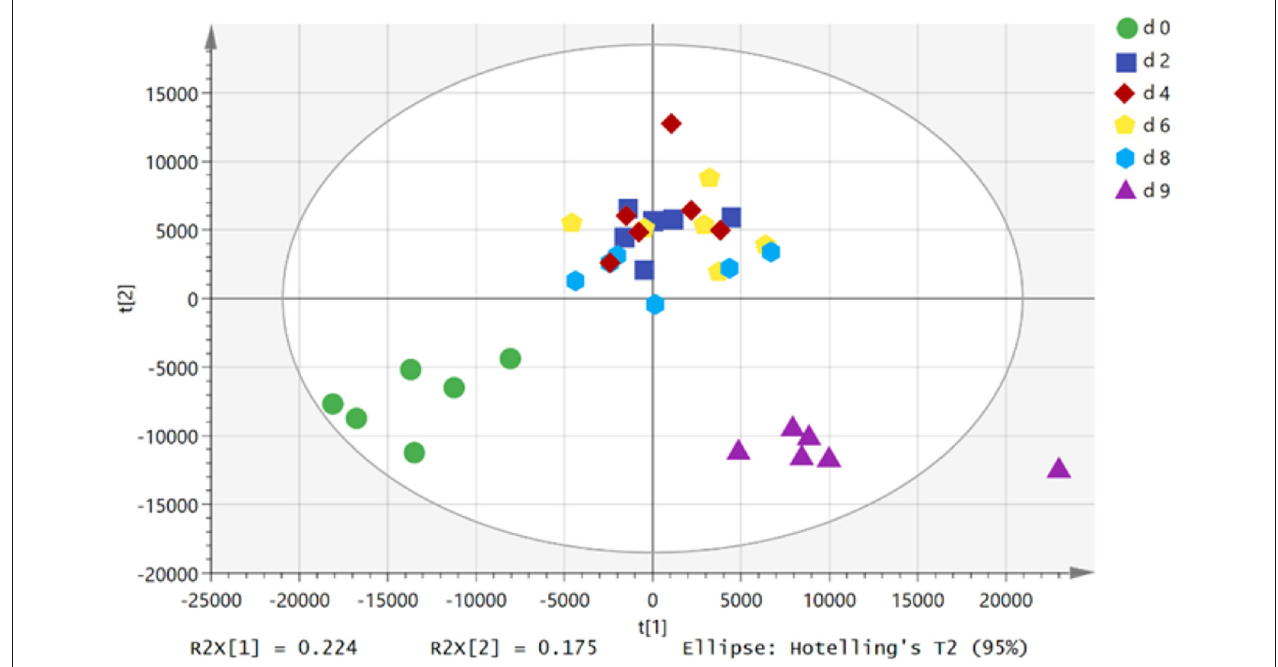
FIGURE 1 | PCA score plots of plasma samples in different treatments. d 0, d 2, d 4, d 6, and d 8 represented 0th, 2th, 4th, 6th and 8th day of feeding level at metabolizable energy for maintenance; d 9, refeeding at 2,400 kJ ME/kg BW 0.6 · d − 1 on d